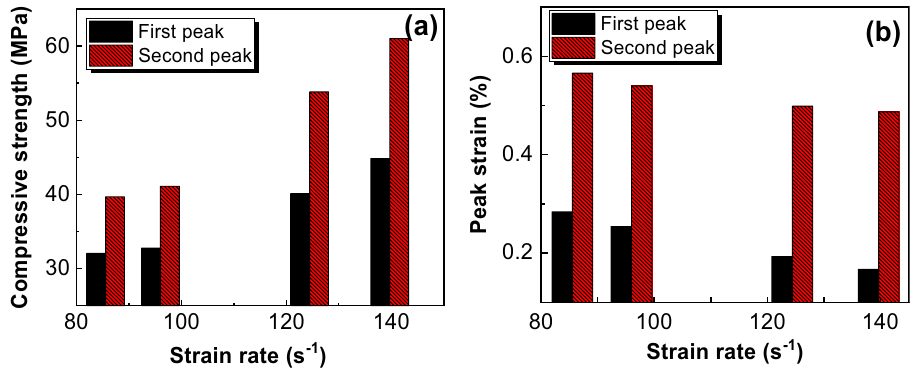
Figure 12. Fitting line of double-peak. ( a ) compressive strength, ( b ) peak strain.